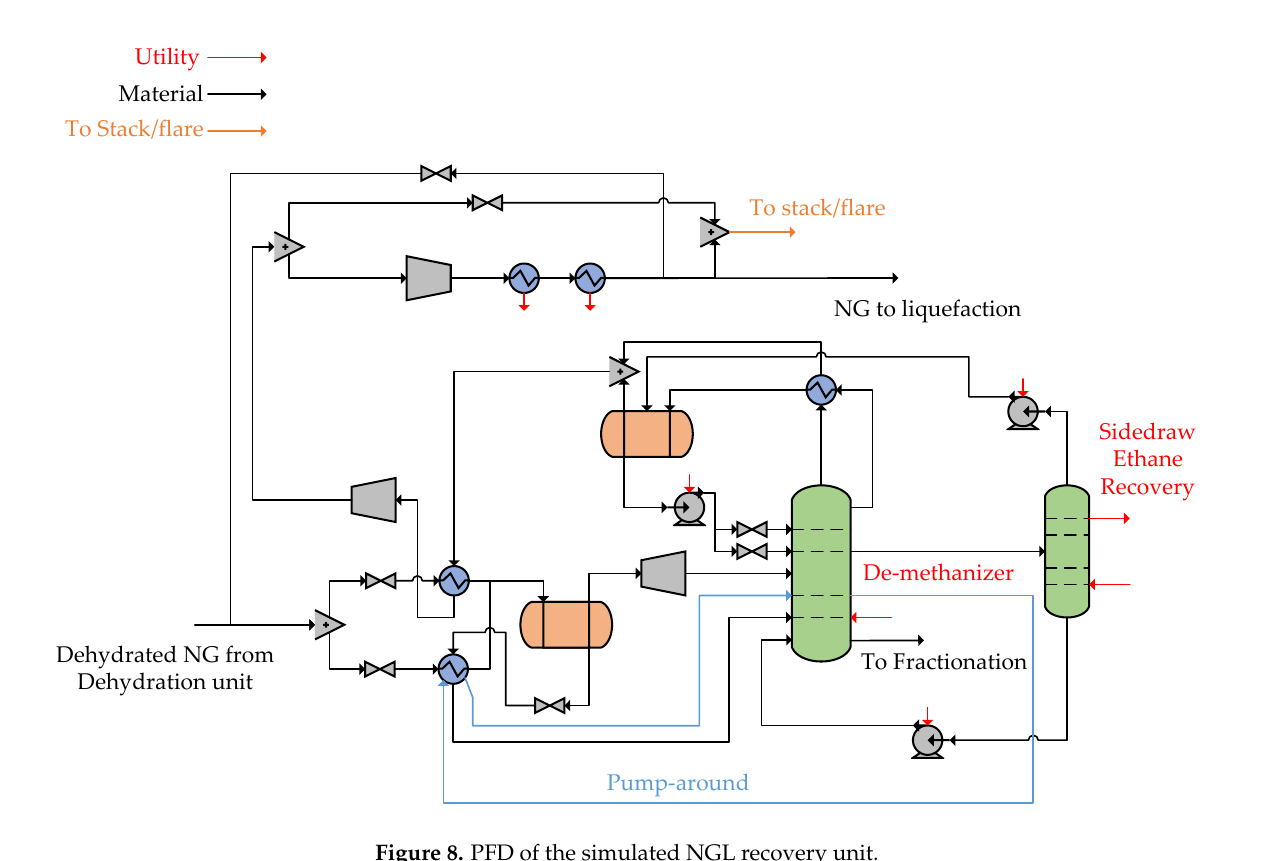
Figure 8. PFD of the simulated NGL recovery unit. Table 8. NG liquefaction unit conditions and specifications.